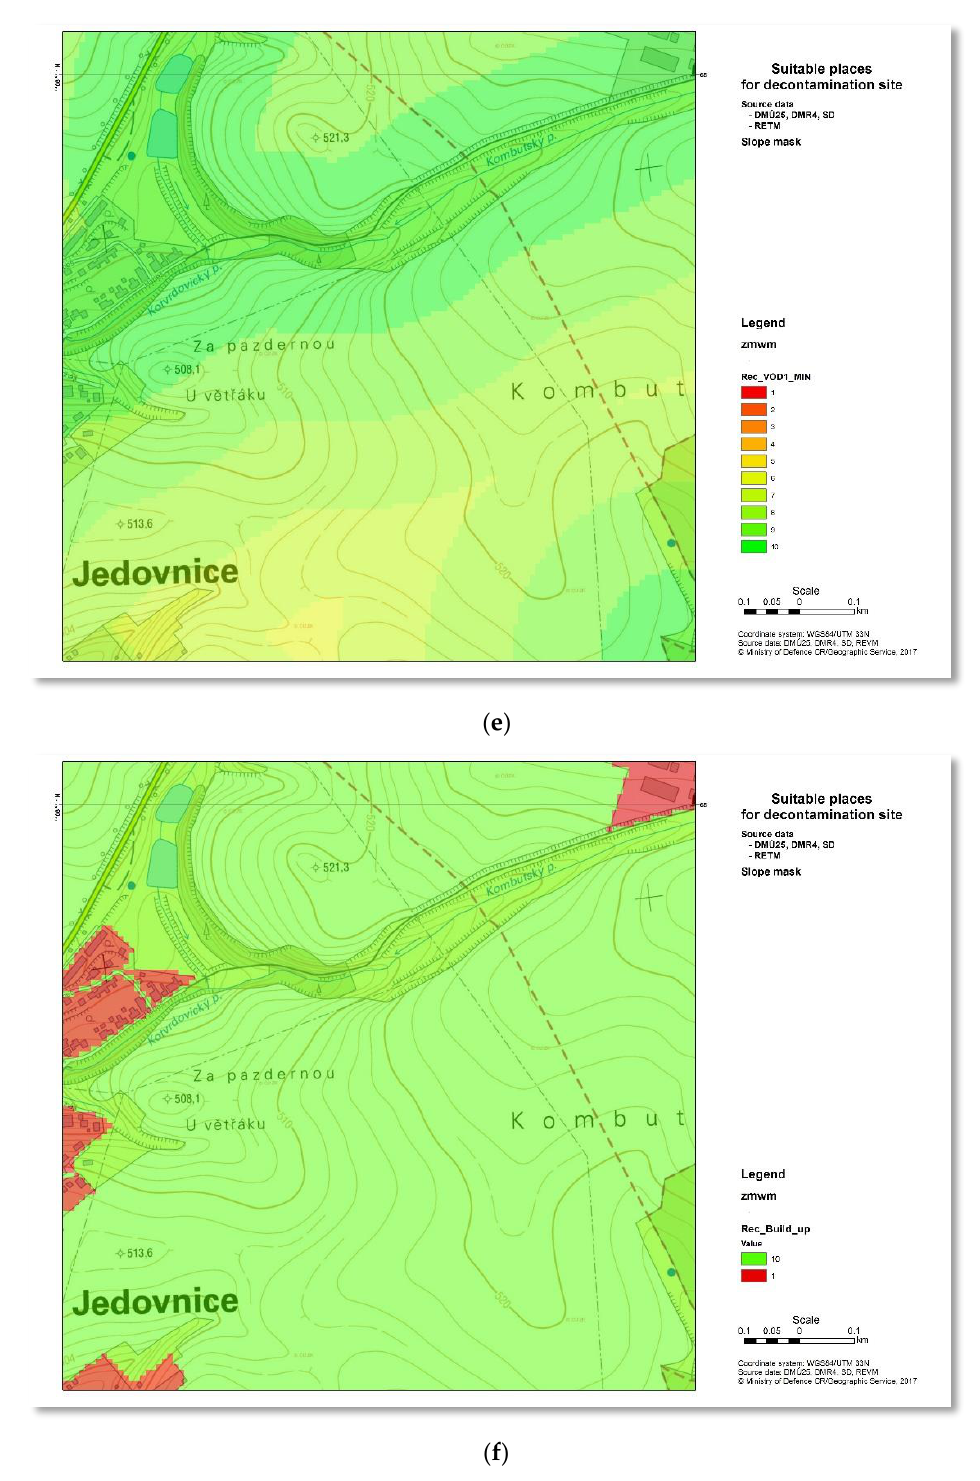
Figure 10. Input reclassified layers for MCA in Jedovnice area: ( a ) slope inclinations, ( b ) soil types, ( c ) roads, ( d ) vegetation, ( e ) hydrology, ( f ) built-up areas. These layers then entered their own variants of the MCA, the outputs of which in the Jedovnice area are shown in the following figure (Figure 11).